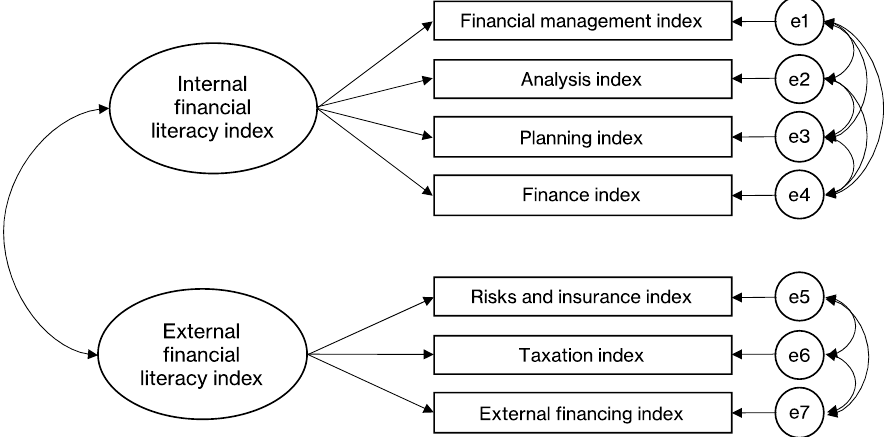
Figure 1. The block diagram of the model, including covariance and error parameters.